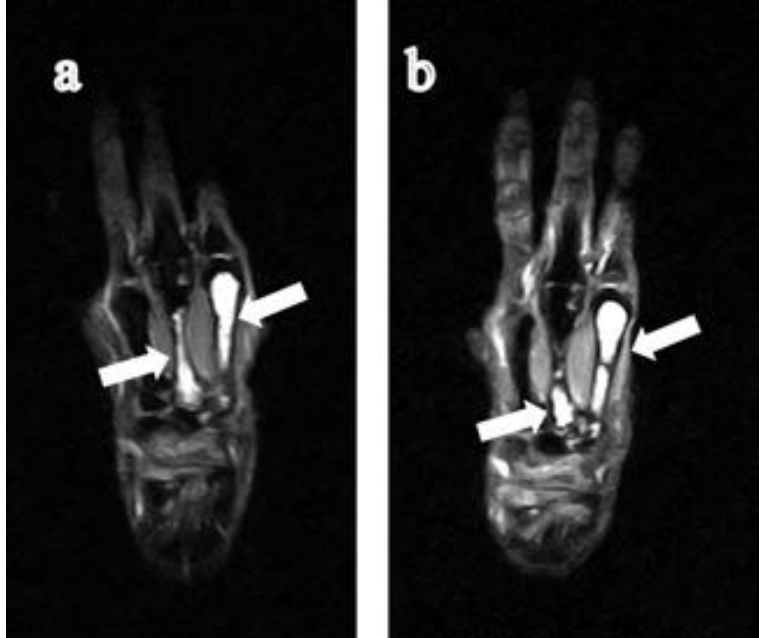
Figure 2. 64-year-old woman with rheumatoid arthritis for five years. ( a ) STIR coronal image shows that the cystic lesions originated from the proximal of the 2nd and 3rd metacarpal bones of the left hand respectively and extended to the central diaphysis. ( b ) During follow-up, the giant intraosseous synovial cyst of the middle finger became smaller. RA, rheumatoid arthritis; STIR, short tau inversion recovery.